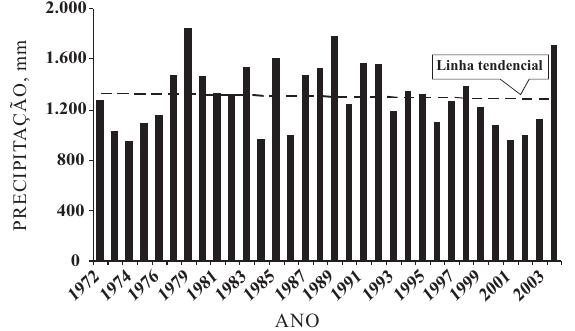
Figura 2. Variabilidade da precipitação pluvial na bacia do rio Pipiripau no período 1972-2005 e linha tendencial da série. Fonte: ANA